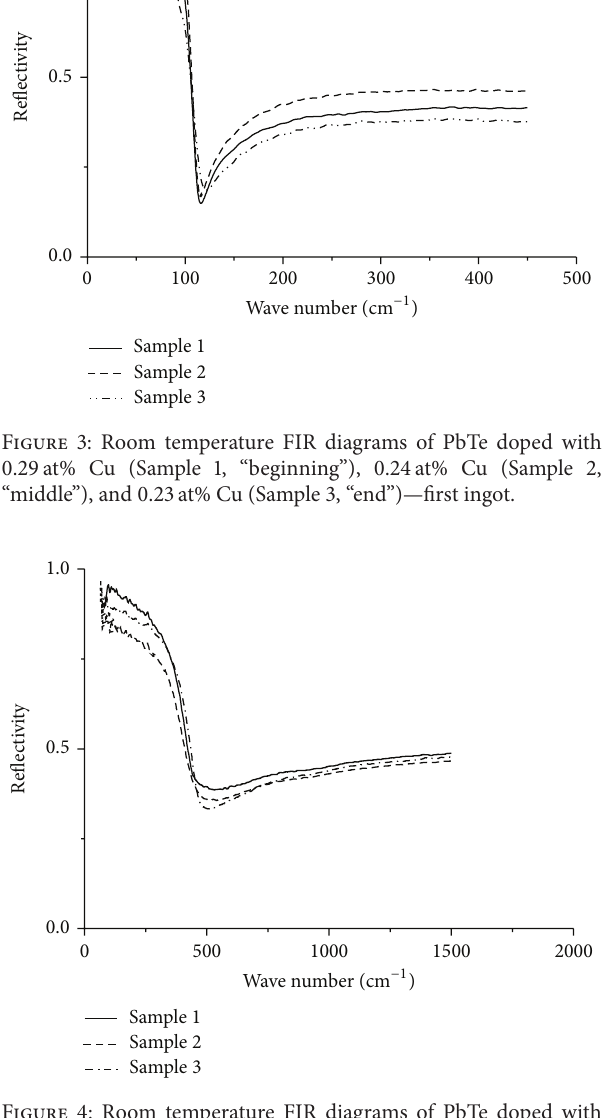
Figure 4: Room temperature FIR diagrams of PbTe doped with 1.7 at% Cu (Sample 1, “beginning”), 1.6at% Cu (Sample 2, “middle”), and 1.4at% Cu (Sample 3, “end”)—second